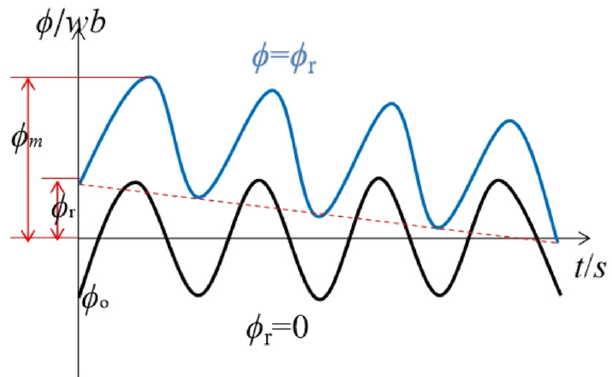
Figure 2. Flux waveforms of ϕ start with the residual flux ϕ r , and ϕ 0 = zero .